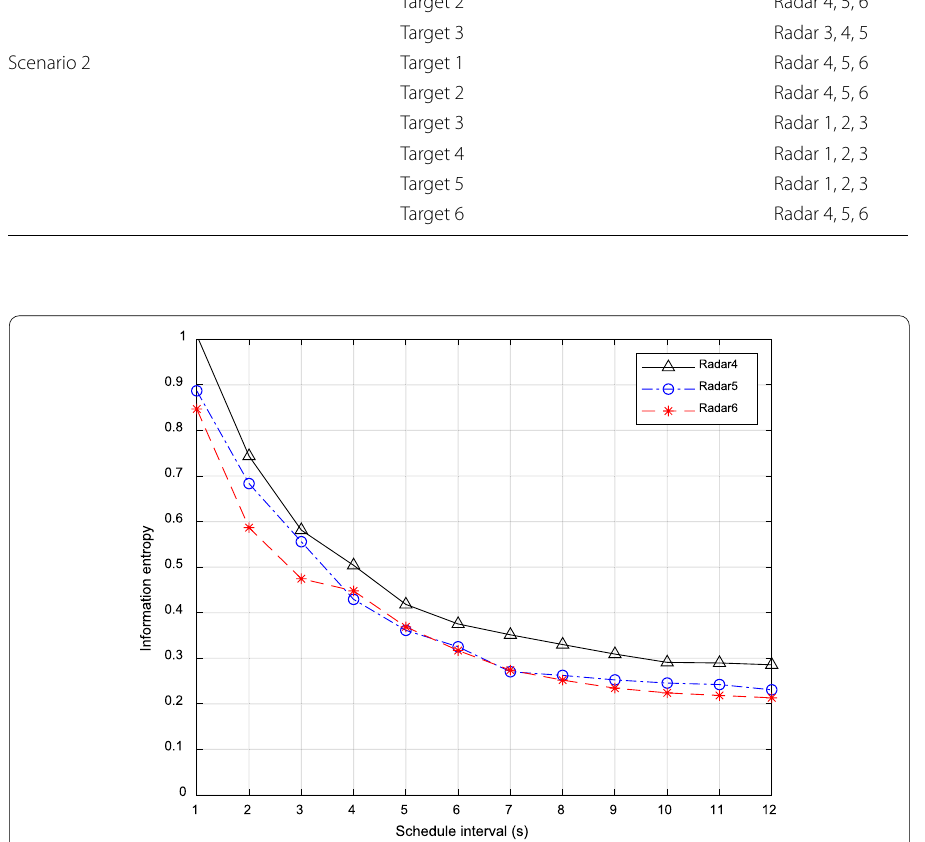
Fig. 11 The curve of the information entropy for Target